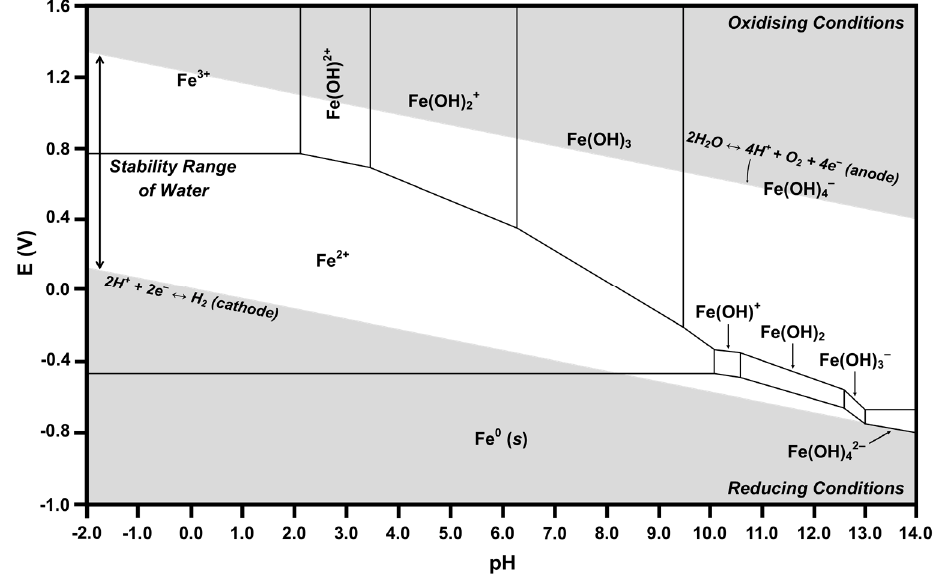
Figure 9. Calculated Pourbaix diagram for Fe ‐ H 2 O.